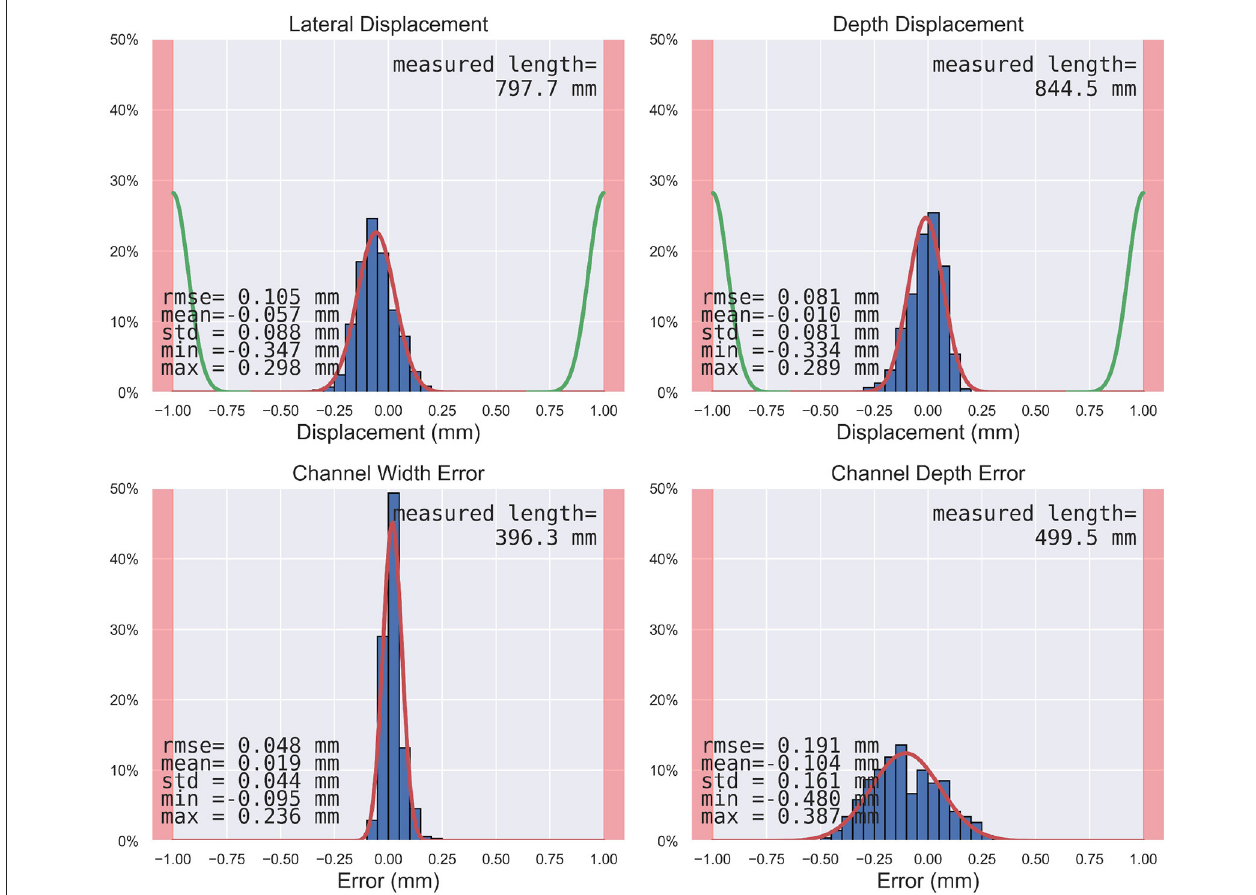
FIGURE 9 | Histograms of the measured endpoints (i.e., lateral displacement, depth displacement, channel width error, channel depth error) in blue, the estimated distribution in red, the segmentation error distribution in green (65) where applicable, and the safety margins as red zones at the sides. The measured length is the length along which the individual measurements were carried out in the resulting channel and